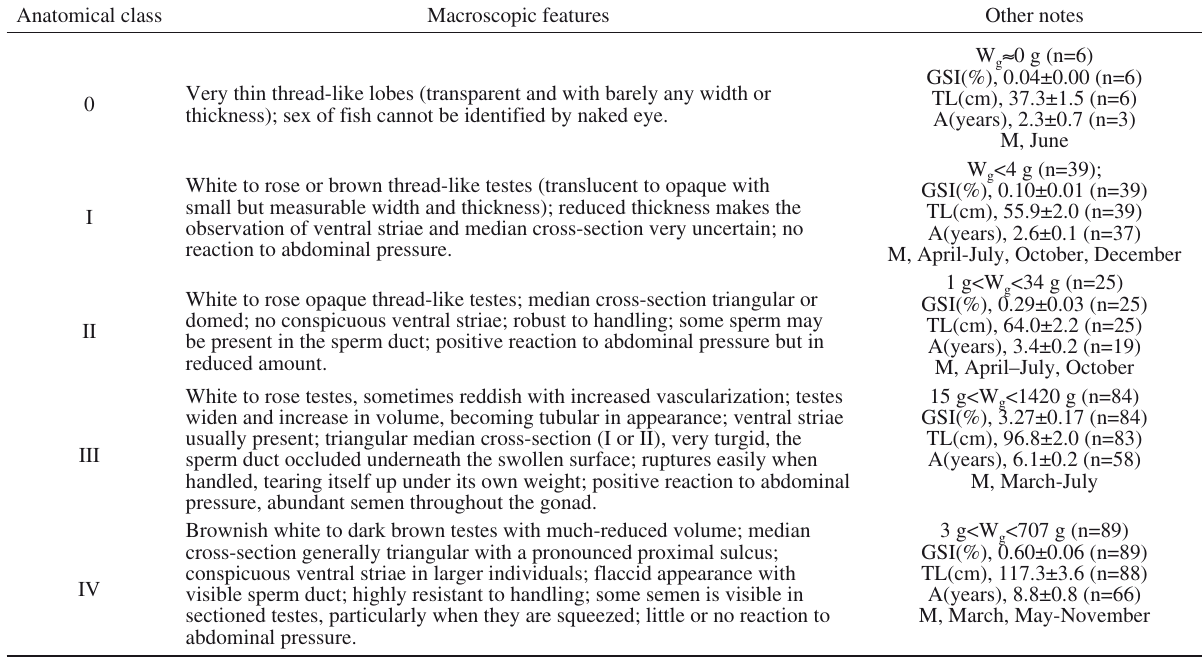
Table 2. – Gross anatomical grading system derived for the meagre testis. W (mean±s.e.); M, month(s) of occurrence. GSI (%) is calculated as (gonad weight/fish total weight)*100 (mean±s.e.). Anatomical